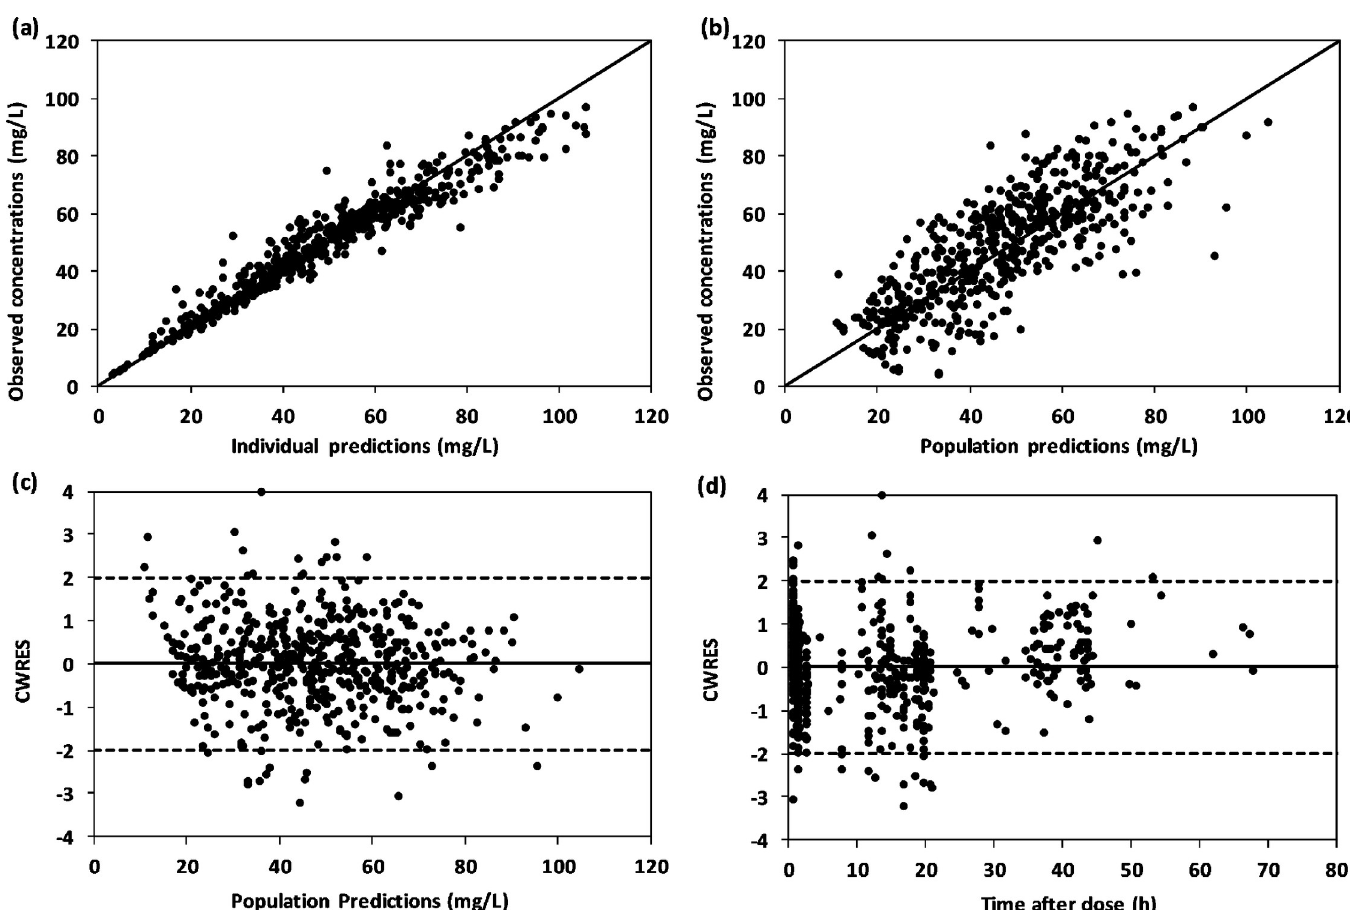
Fig 2. Goodness-of-fit plots of final model showing observed concentrations vs. individual predictions (a), observed concentrations vs. population predictions (b), CWRES vs. population predictions (c) and CWRES vs. time after dose (d).